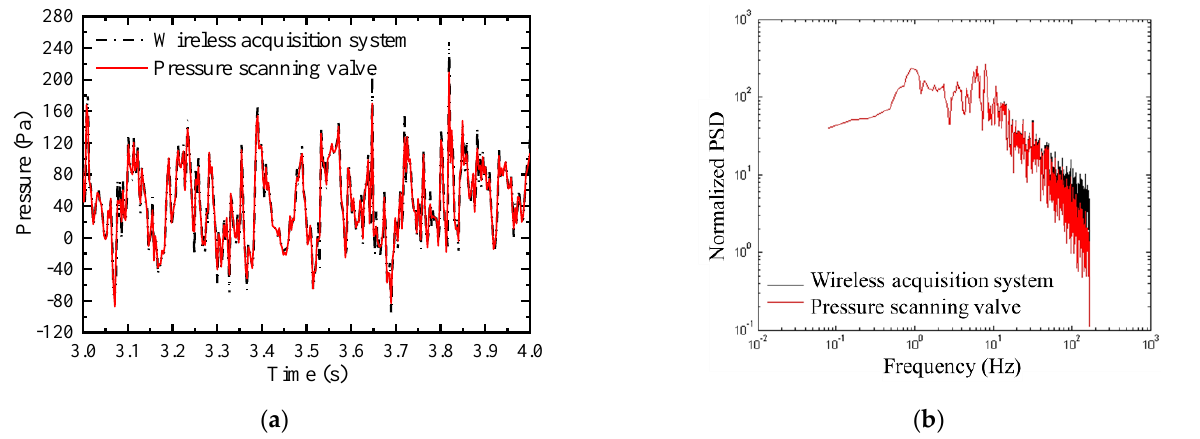
Figure 7. Comparison of wind pressure test results between the wireless acquisition system and pressure scanning valve system in the ( a ) time domain; ( b ) frequency domain.